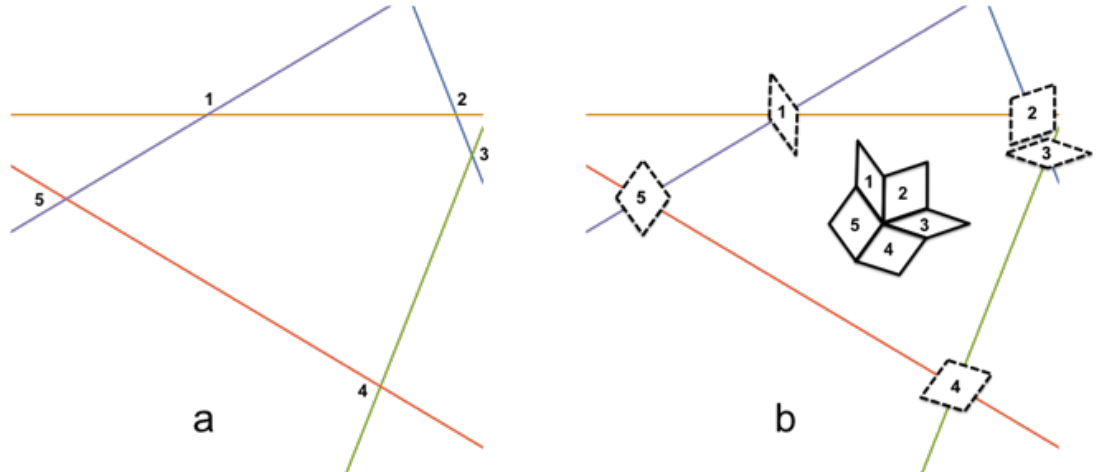
Figure 6. The dualizing procedure for generating a Penrose tiling from a pentagrid. To construct a Penrose tiling, first we identify the intersections in a sample patch in the pentagrid ( a ) and then we construct a dual quasicrystal cell, here the prolate and oblate rhombuses, at each intersect point, placing them edge to edge while maintaining their topological connectedness ( b